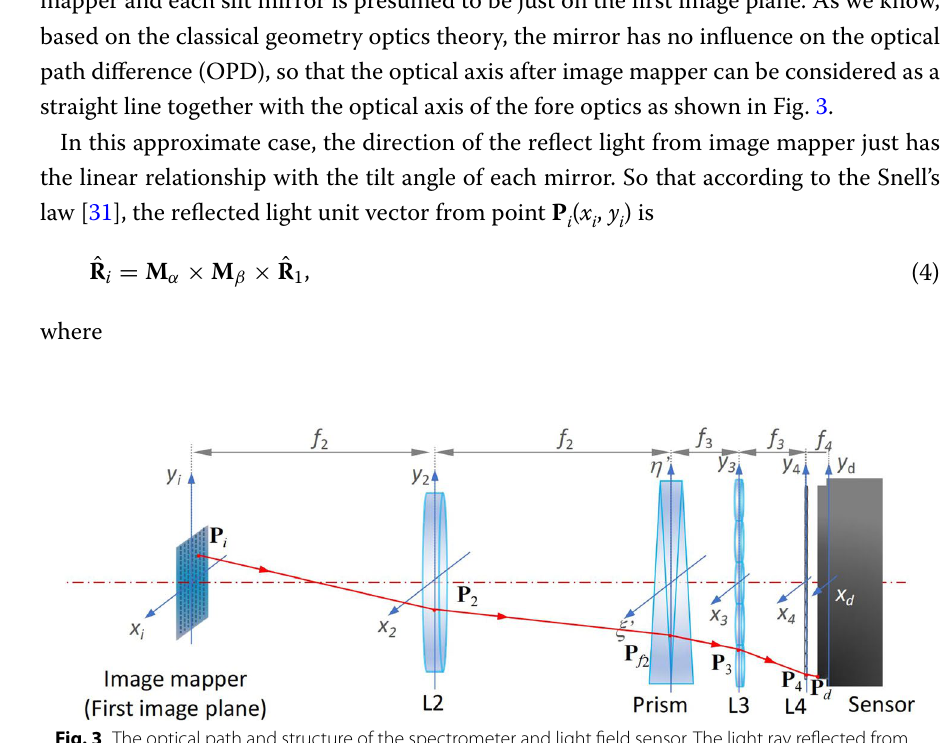
Fig. 3 The optical path and structure of the spectrometer and light field sensor. The light ray reflected from image mapper intersects L2, the prism, L3, L4 and the sensor at P 2 , P f 2 , P 3 , P 4 and P d